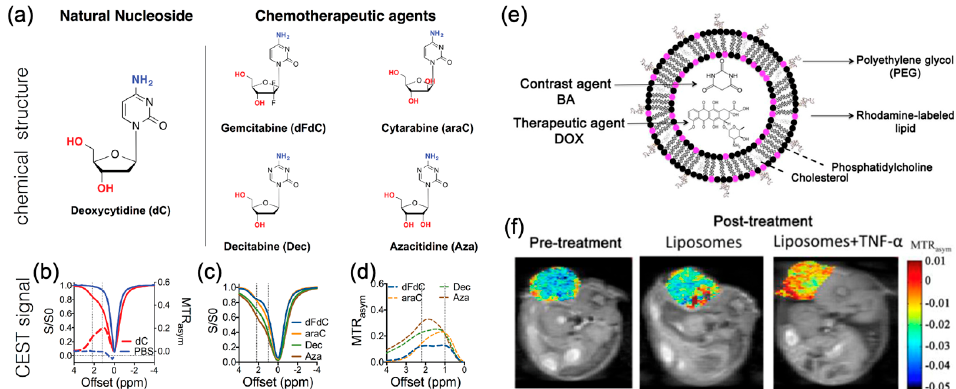
Figure 3. Contrast agent/drug-loaded liposome for CEST imaging. ( a ) The chemical structure of cytidine-based agents and ( b – d ) their CEST MRI contrast, as shown both by z-spectra ( b , c ) and MTR asym plots ( b , d ). ( e ) Cartoon depicting the contrast agent/therapeutic agent (BA/DOX) co-loaded liposome. ( f ) MTR asym maps at 5 ppm for a mouse bearing CT26 subcutaneous tumors before and after treatment with BA/DOX co-loaded liposome. Reproduced with permission from [147], Impact Journals, 2016; [153], Elsevier, 2014.